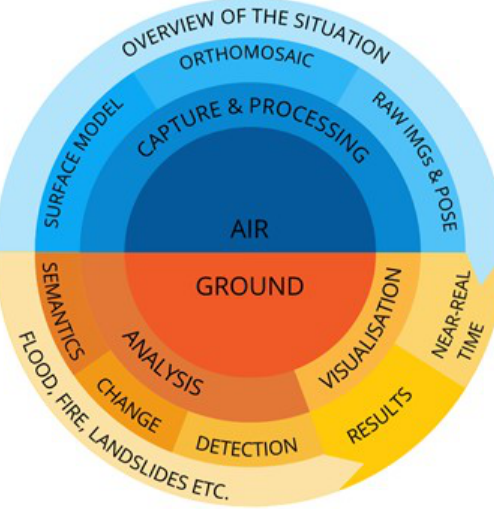
Figure 1. UAV mapping design scheme